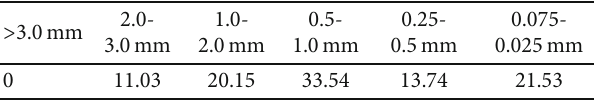
Table 1: Grain size composition of the tested sand (unit: %). > 3.0mm